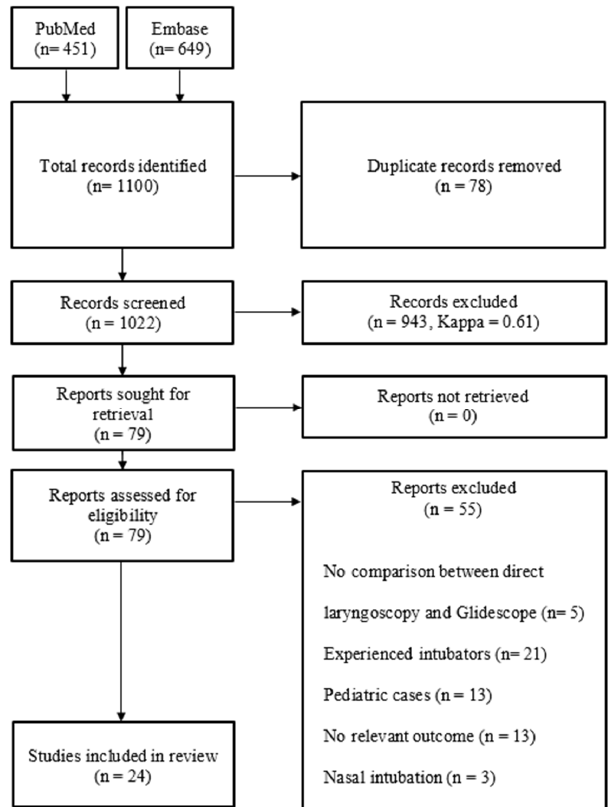
Figure 2. PRISMA